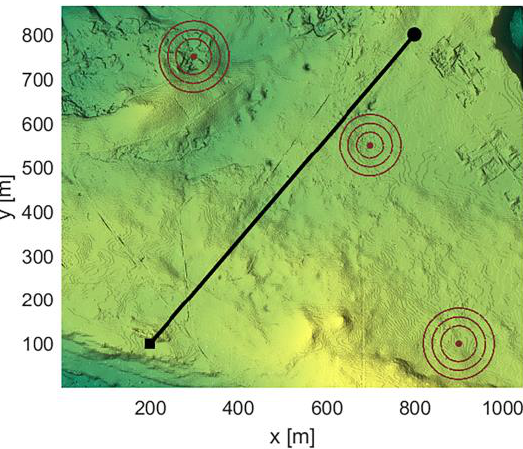
Figure 15. The top view of the paths generated by the IC-VAINDIWPSO algorithm under three